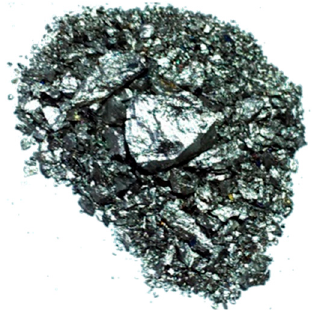
Figure 3. Refined manganese metal.